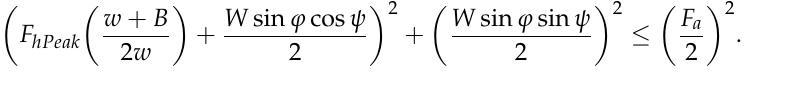
Figure 6. Anti-slip stability diagram of mining vehicle with up-milling cutting head. 2